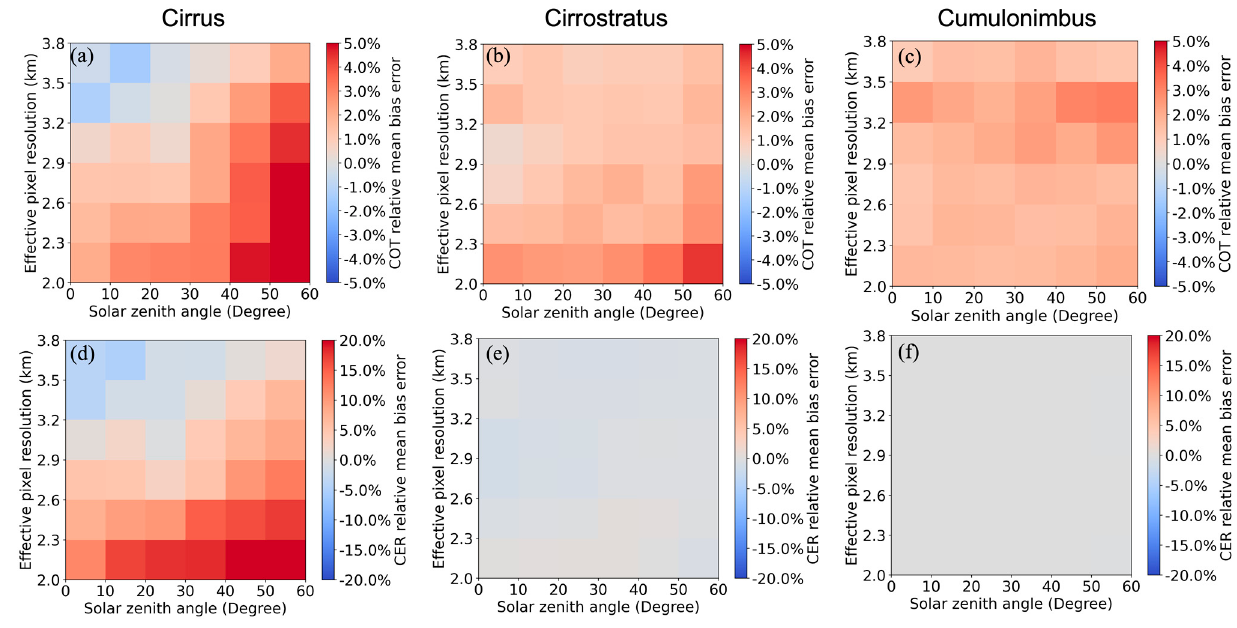
Figure 7. 2-D histogram of the COT and CER retrieval relative mean bias errors for Cirrus ( a , d ), Cirrostratus ( b , e ), and Cumulonimbus ( c , f ) as a function of SZA (x-axis) and effective pixel resolution (y-axis). The colors depict the relative mean bias error, defined as the difference of the retrieved COT or CER of Case C minus Case A.